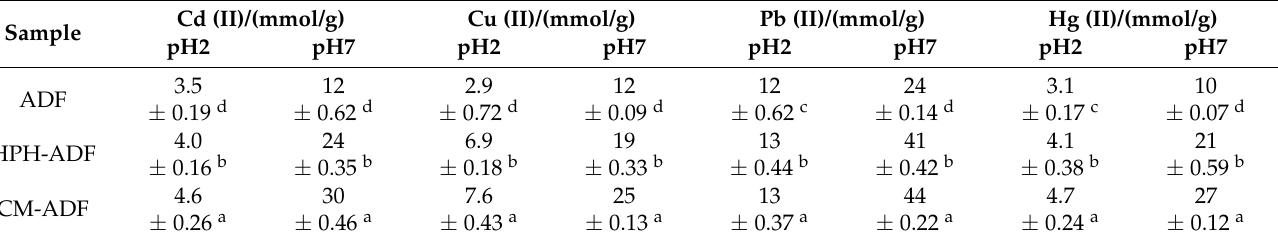
Table 4. ADF adsorption capacity of heavy metal